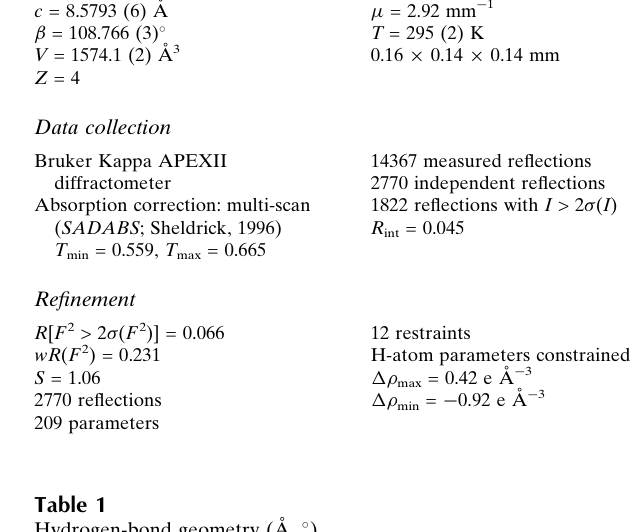
Hydrogen-bond geometry (A˚ , (cid:1)